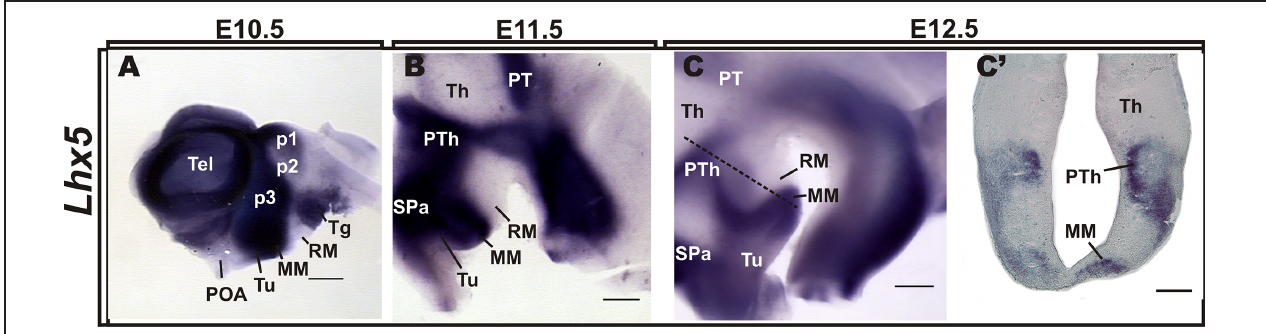
FIGURE 1 | Expression patterns of Lhx5 in the developing hypothalamus. In situ hybridization for Lhx5 in whole-mount brain preparations of E10.5 (A) , E11.5 (B), and E12.5 (C) embryos and in a section indicated in (C) by the dashed line (C’) . Whole hybridized brains were hemisected along the sagittal plane and lateral views are shown (anterior is to the left). Abbreviations: Th, thalamus; MM, mamillary body; p, prosomere; POA, preoptic area; PT, pretectum; PTh, prethalamus; RM, retromamillary; SPa, subparaventricular area; Tel, telencephalon; Tg, tegmentum; Tu, tuberal. Scale bars: (A–C) 400 µ m, (C’) 200 µ m.